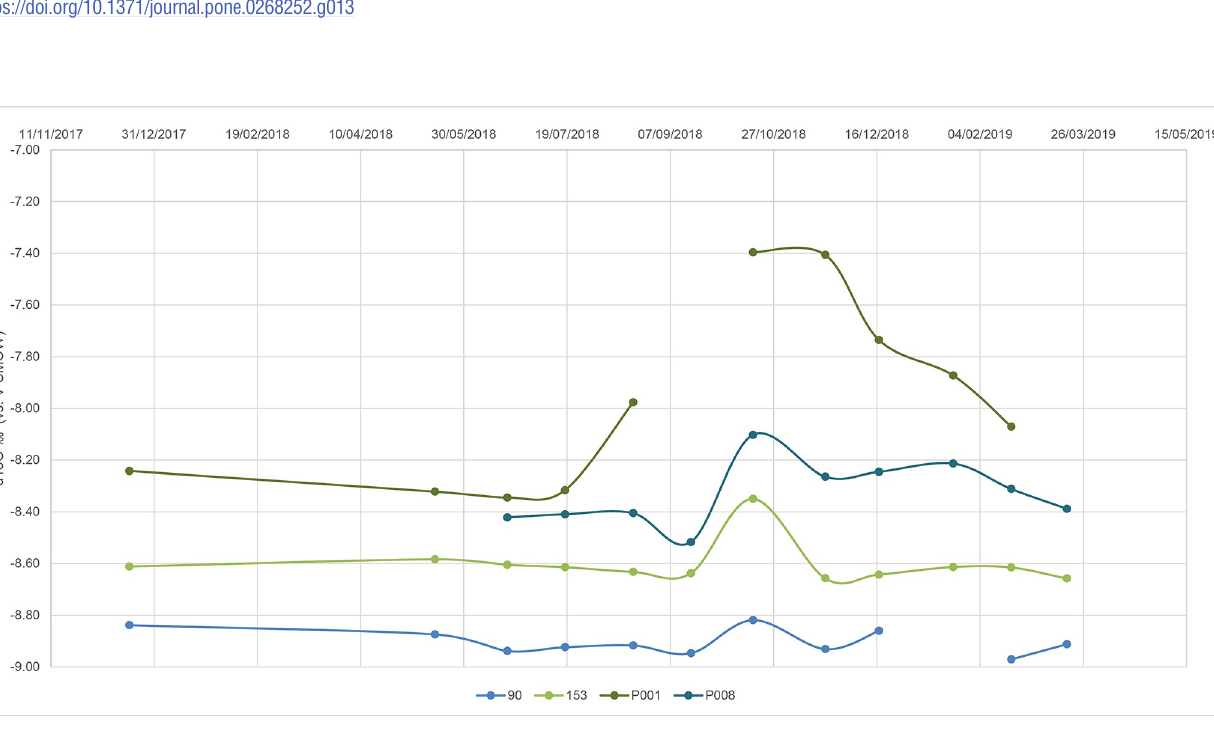
PLOS ONE | https://doi.org/10.1371/journal.pone.0268252 May 6,